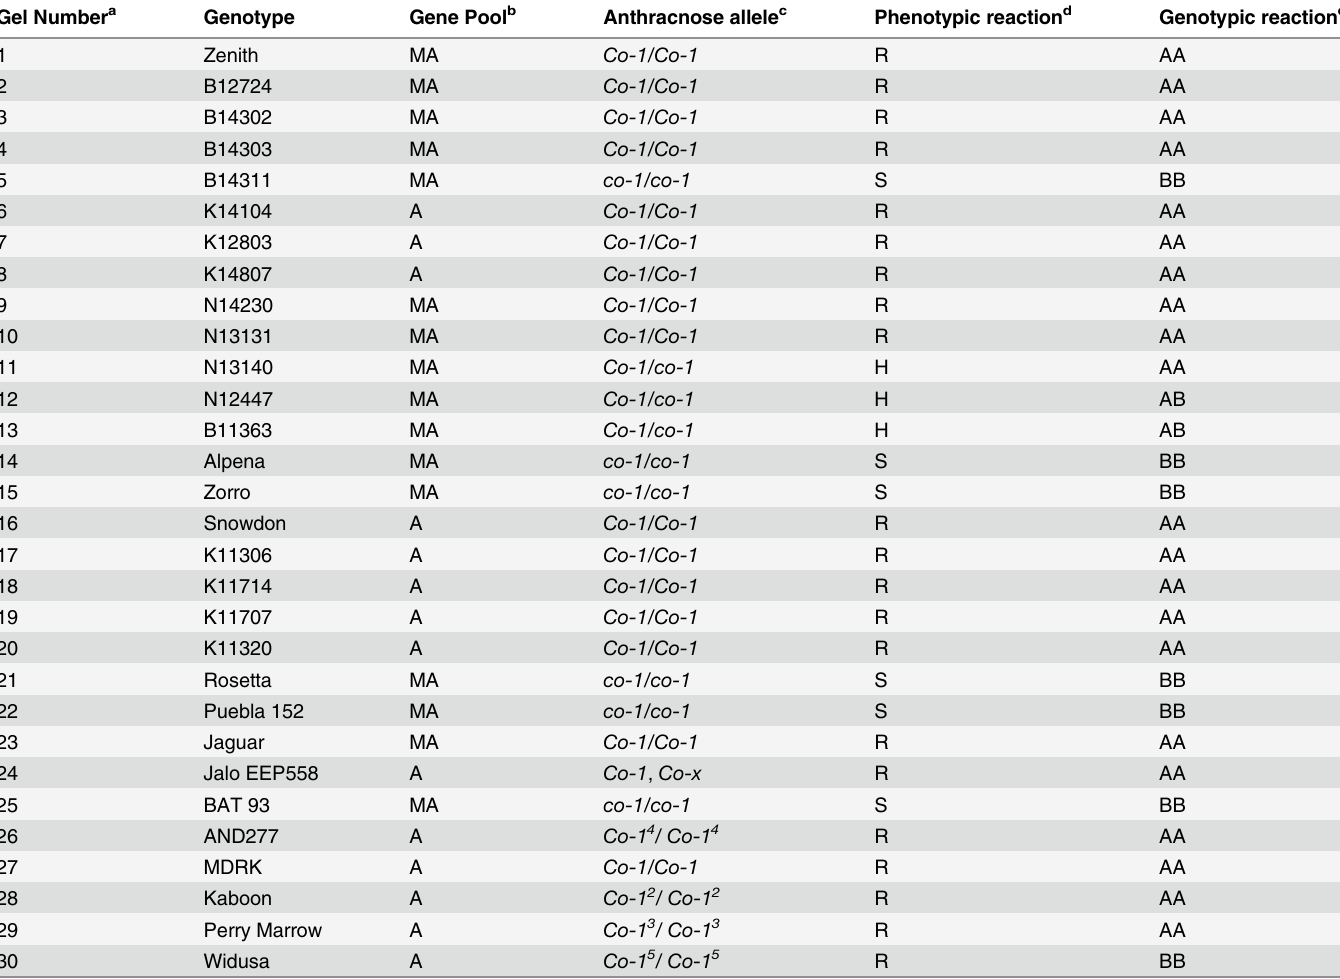
a gel number shown in S2 Fig b MA = Mesoamerica, A = Andean gene pool of host genotypes] c anthracnose resistance alleles at the Co-1locus